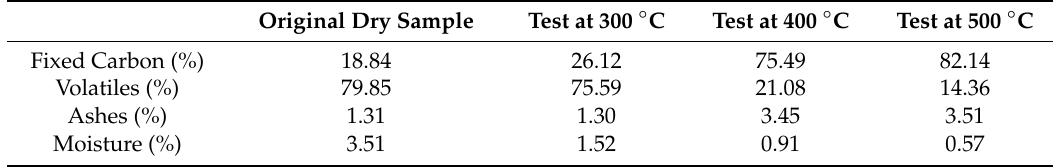
Table 3. Proximate composition for the di ff erent process